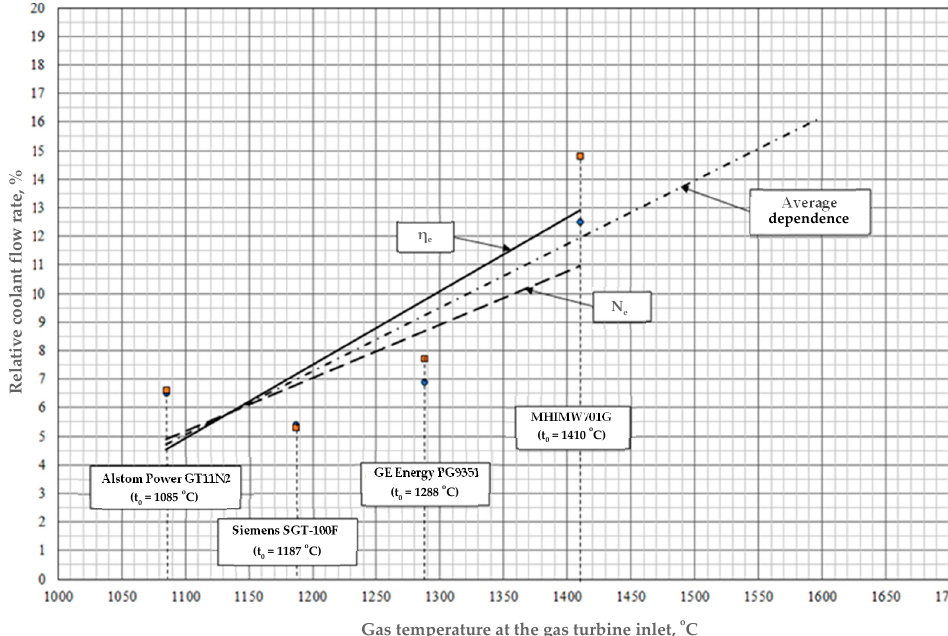
Figure 6. Dependences of temperature changes in exhaust gases of GTU with different levels of power and temperatures on the relative flow rate of the coolant.